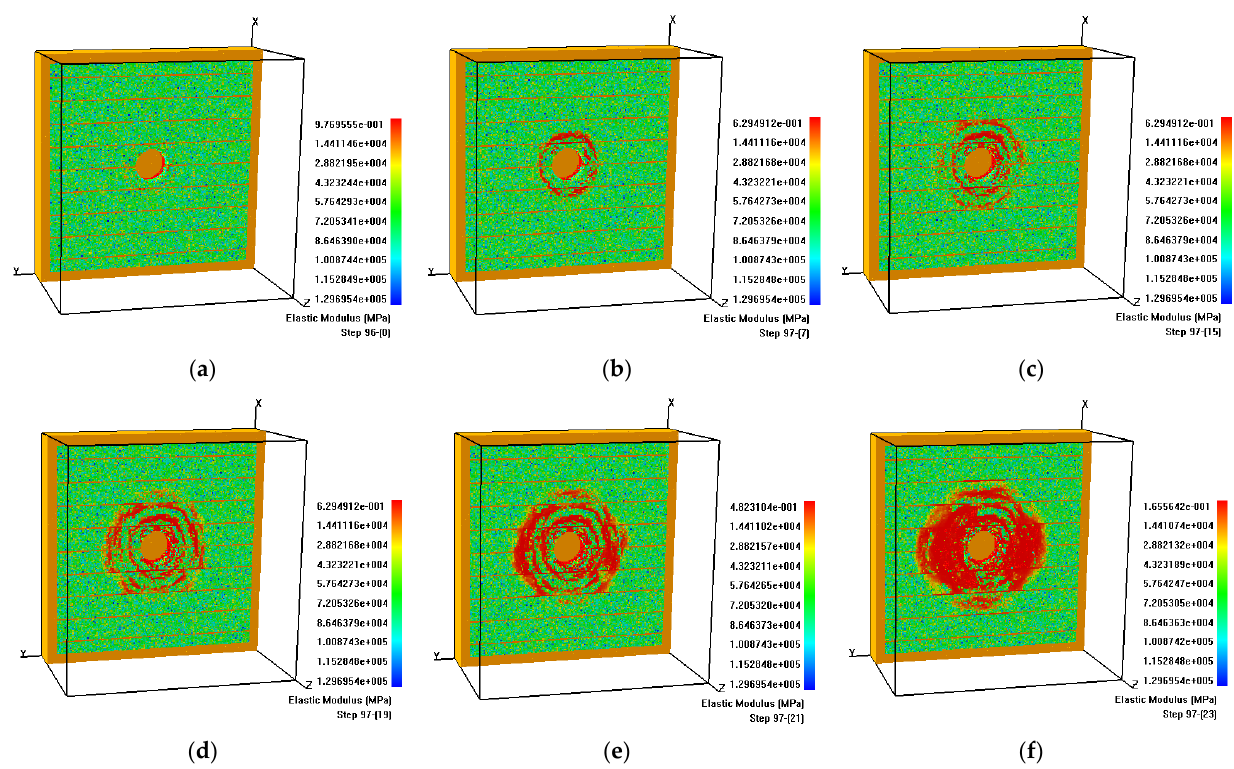
Figure 8. Distribution of elastic modulus during zonal disintegration process of surrounding rock with Model B0: ( a ) Step 96-0; ( b ) Step 97-7; ( c ) Step 97-15; ( d ) Step 97-19; ( e ) Step 97-21; ( f ) Step 97-23.